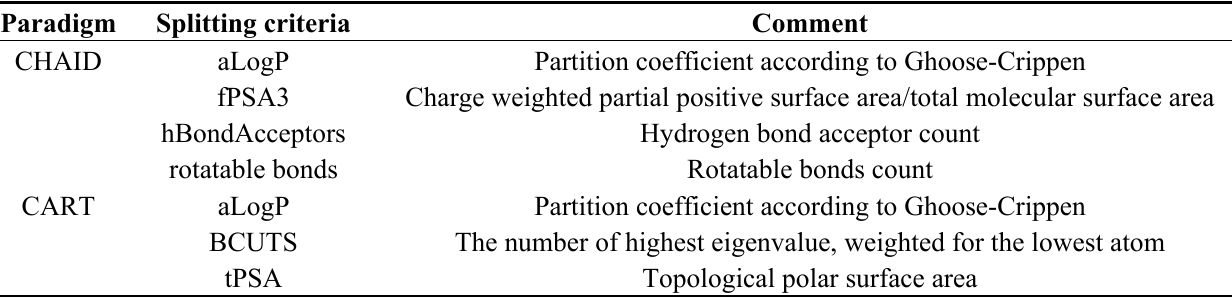
Table 2. Features revealed by decision tree induction (DTI) to predict brain penetration (logPS). Definition of selection criteria used for the DTI paradigms shown in Figure 1 and Figure